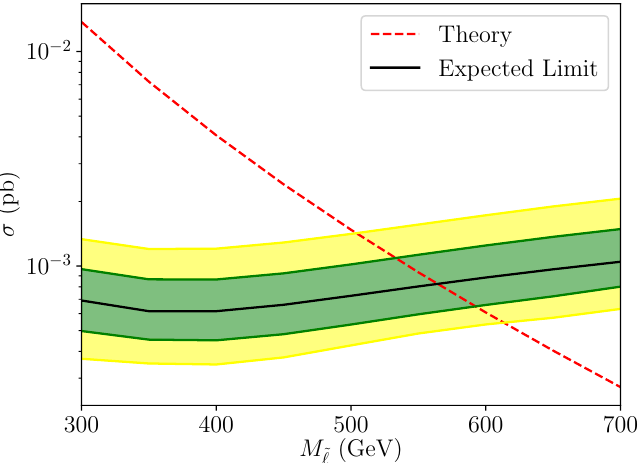
Figure 6 . Limit on the slepton mass, M ˜ in